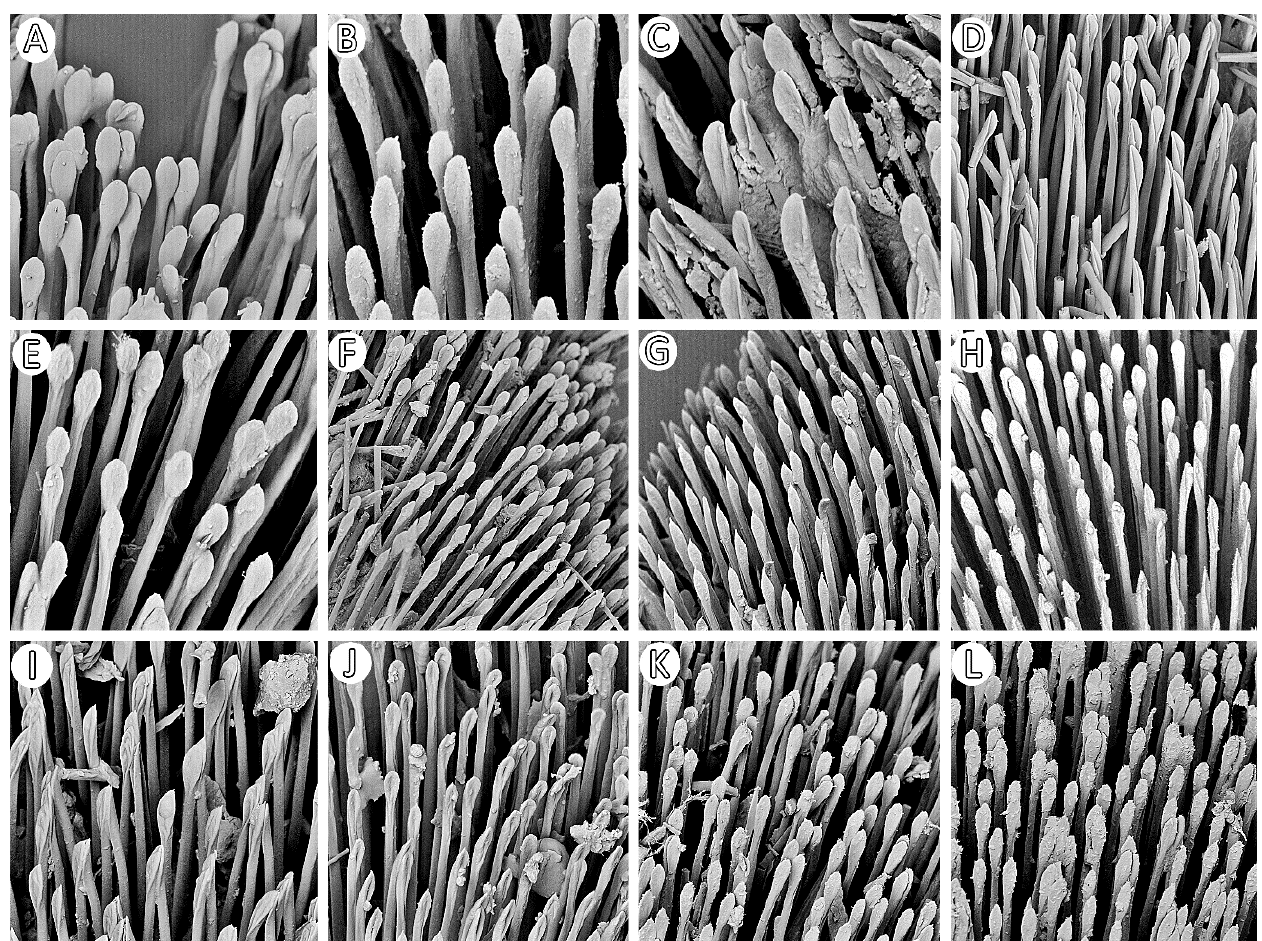
Figure 24. Tenant hairs on a fossula spongiosa of ( A ) Phonoctonus fasciatus (Beauvois, 1805); ( B ) P. immitis Stål, 1865; ( C ) P. nigrofasciatus Stål, 1855; ( D ) P. elegans Varela, 1904; ( E ) P. fairmairei Villiers, 1948; ( F ) P. picturatus Fairmaire, 1858; ( G ) P. picta Schouteden, 1932; ( H ) P. luridus Miller, 1950; ( I ) P. lutescens (Guérin-Méneville & Percheron, 1834); ( J ) P. principalis Gerstaecker, 1892; ( K ) P. grandis Signoret, 1860; and ( L ) P. caesar Haglund, 1895. Abdomen : Fusiform; connexivum medium-sized, covered by hemelytra in the dorsal view. The ventral portion of the abdomen is u-shaped in cross-section with a slightly flattened medial portion (Figure 26). Spiracles are on each abdominal segment (Figure 27). Inside the spiracle are several rows of air-filtering cilia (Figure 27D,E). Sensory field is at the contact area of the thorax and abdomen (Figure 27C). All along the ventral, external margin of connexives are single sensilla chaetica type I (Figure